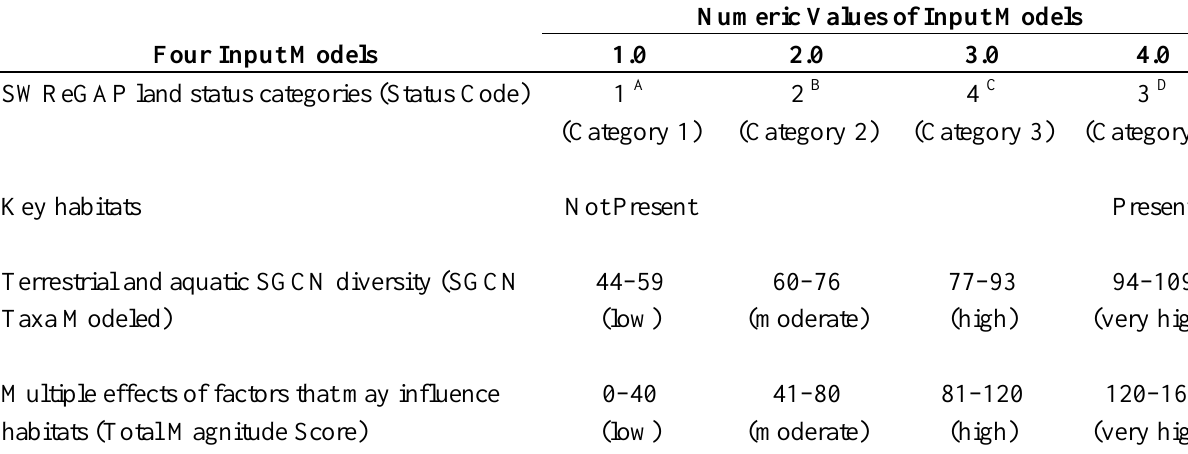
Table 1. Criteria used to code model inputs to numeric values from 1–4 to identify landscapes that may be key areas for focusing conservation